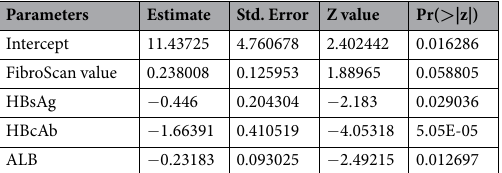
Table 2. Parameters Included in the Logistic Regression Model.